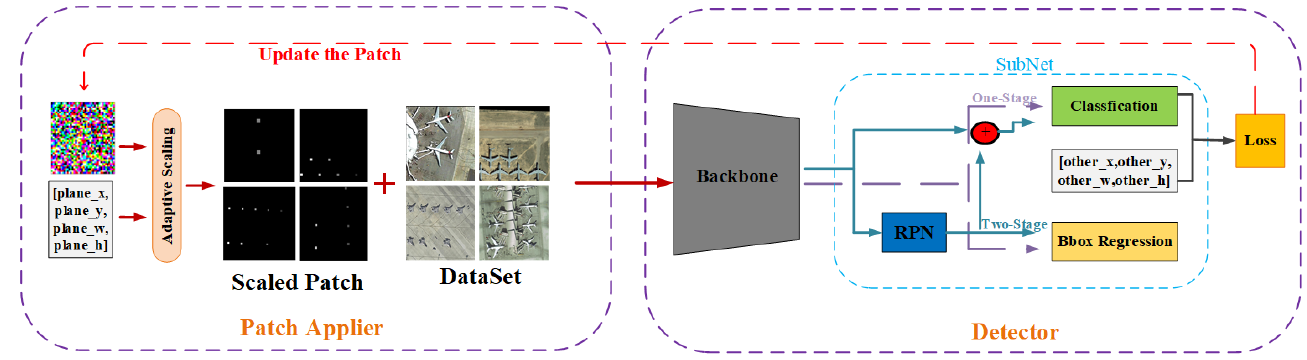
Figure 1. Overview of the framework of